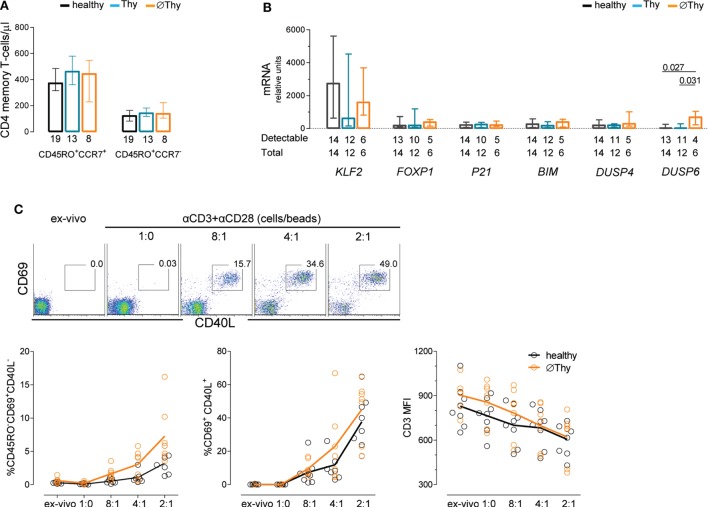
Maintenance of naive CD4 T-cell quiescence upon thymectomy. (A) Absolute numbers of circulating central memory (CD45RO+CCR7+) and effector memory (CD45RO+CCR7−) cells in thymectomized patients without (∅Thy) and with evidence of thymic activity (Thy), as well as age-matched healthy individuals; numbers below the graph indicate the number of individuals. (B) mRNA expression levels of genes involved in cell cycle or maintenance of naive phenotype quantified in purified naive CD4 T-cells from the three cohorts; ΔCT normalized to the medium CT levels of GAPDH and HPRT are shown; numbers below the graph indicate the total number of samples tested and those with levels above the detection threshold of the respective gene. (C) Purified naive CD4 T-cells from ∅Thy and healthy individuals were stimulated (6 h) with increasing concentrations of beads coated with anti-CD3 and anti-CD28 monoclonal antibodies with dot plots illustrating the upregulation of the activation markers CD40L and CD69 in one ∅Thy subject, and graphs showing frequencies of CD69+CD40L− cells (left), CD69+CD40L+ cells (middle), and CD3 mean fluorescence intensity (right); each dot represents one individual; lines connect means; and the two cohorts were compared with two-way ANOVA. Bars represent median and interquartile range. P values <0.05 are shown.